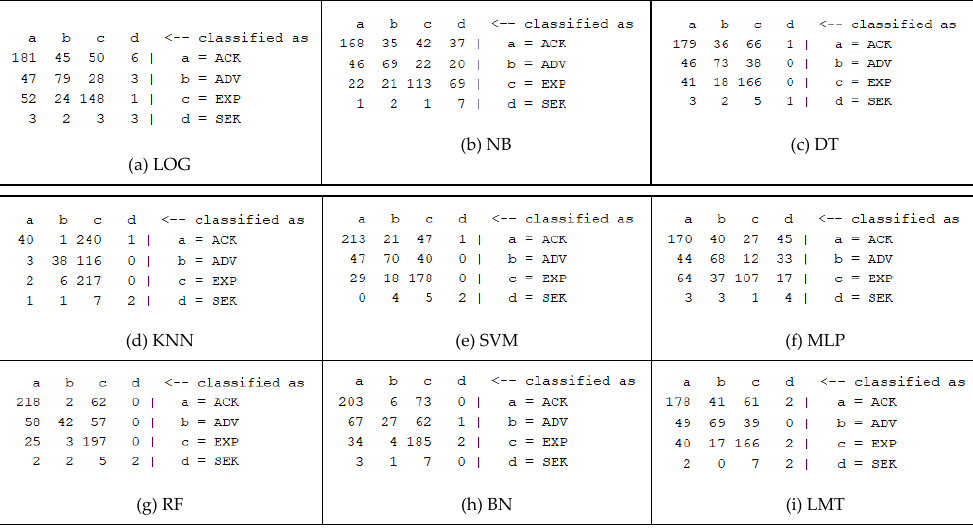
Figure 11. Confusion matrices.